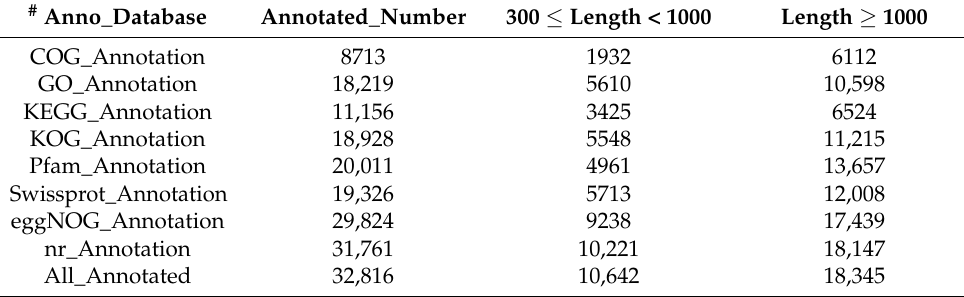
Table 1. Annotation and statistics of unigenes.